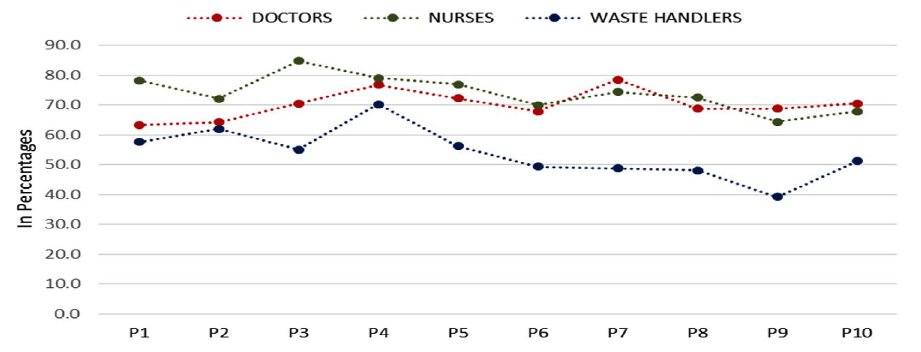
Fig. 2. BMWM adequacy of existing practices among healthcare